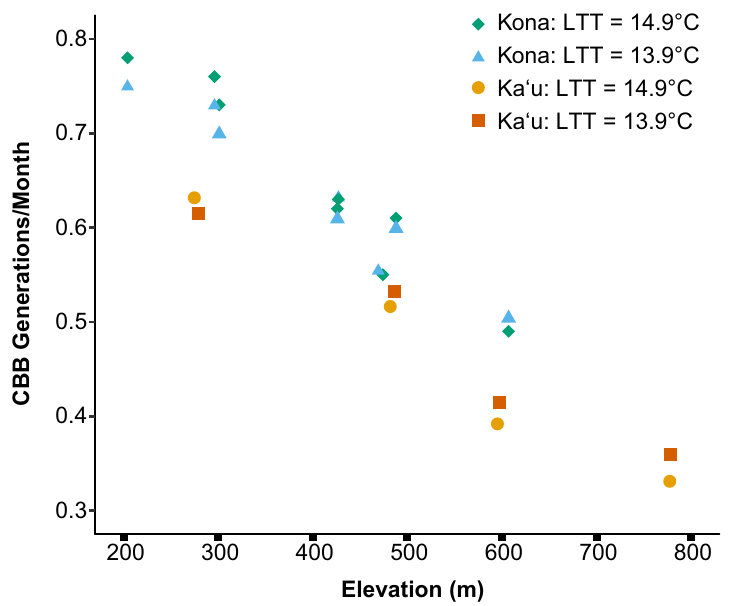
Fig 4. Mean number of CBB generations per month assuming a 332-degree day development requirement (LTT = 14.9˚C) and a 386-degree day development requirement (LTT = 13.9˚C) from berry infestation by the founding female to maturation of F1 offspring. Calculations were based on temperature data collected from January–December 2017 at 12 commercial coffee farms ranging in elevation from 204 to 778 m on Hawai‘i Island (Kona = 8, Ka‘u = 4).